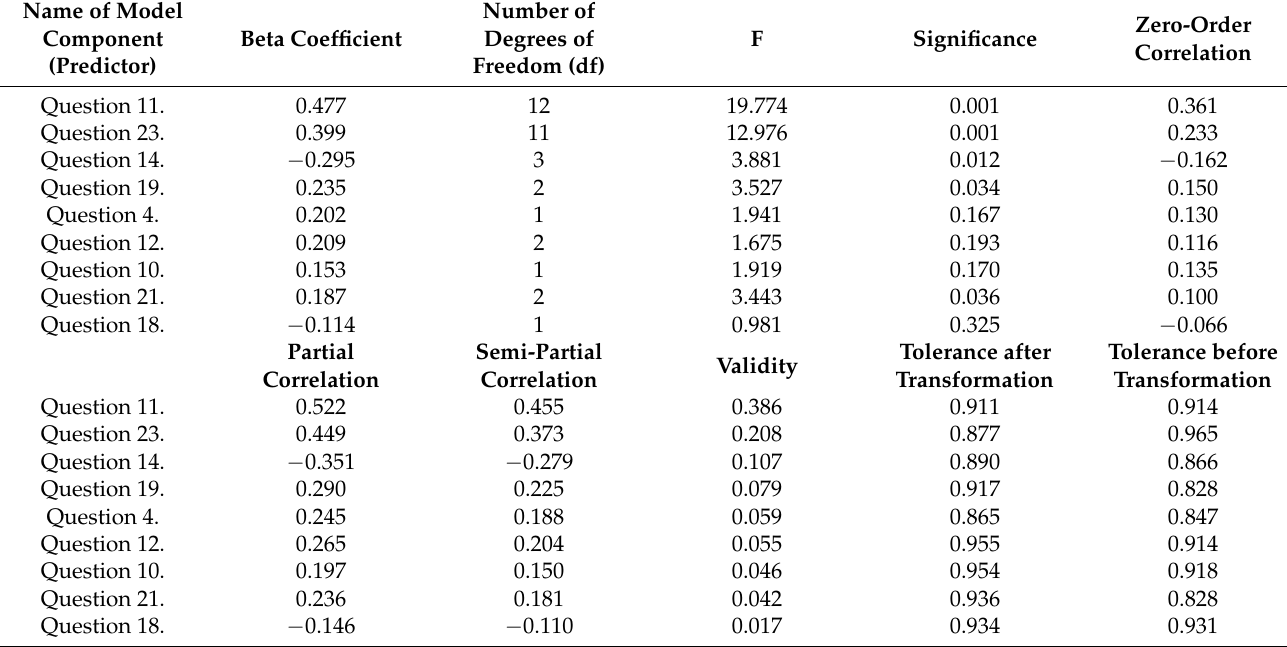
Table 7. Components of the optimal scaling model obtained by the descending